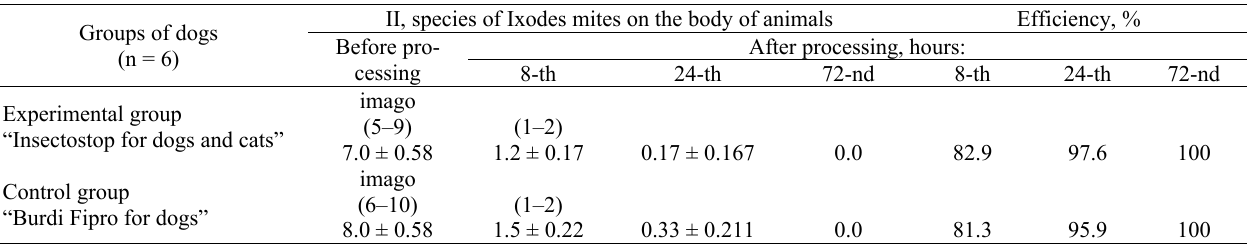
Efficiency of the drug “Insectostop for dogs and cats” and the reference drug “Bourdi Fipro for dogs” for Ixodidoses of dogs (M ± m) II, species of Ixodes mites on the body of animals Efficiency, % Groups of dogs Before pro- (n = 6) cessing Experimental group “Insectostop for dogs and cats” Control group “Burdi Fipro for